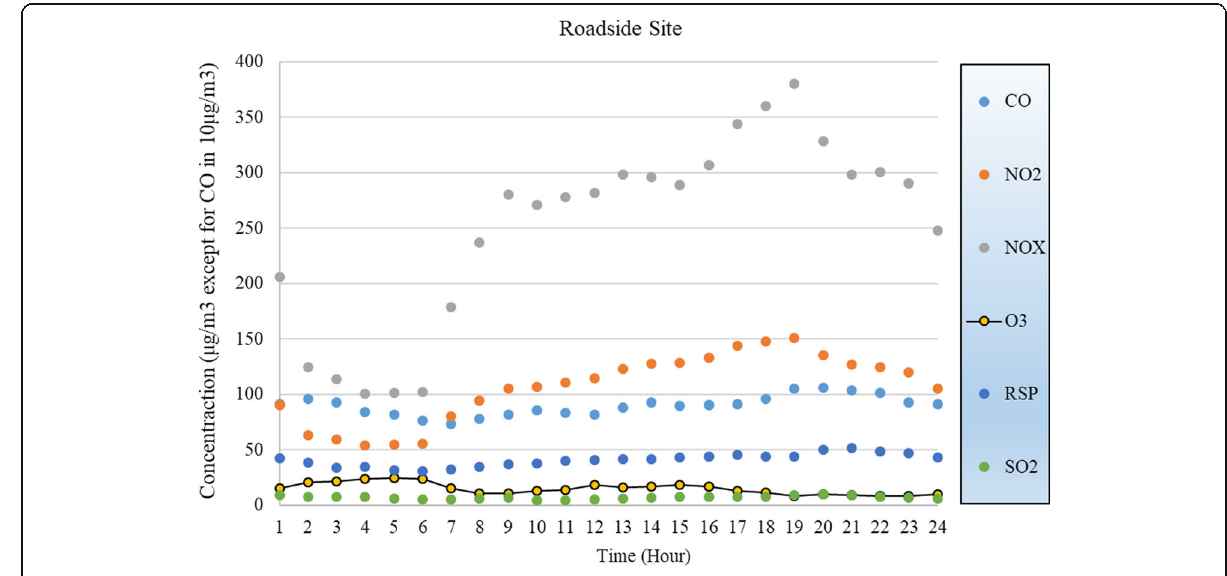
Fig. 7 Air quality parameters at a roadside site (Mong Kok, Hong